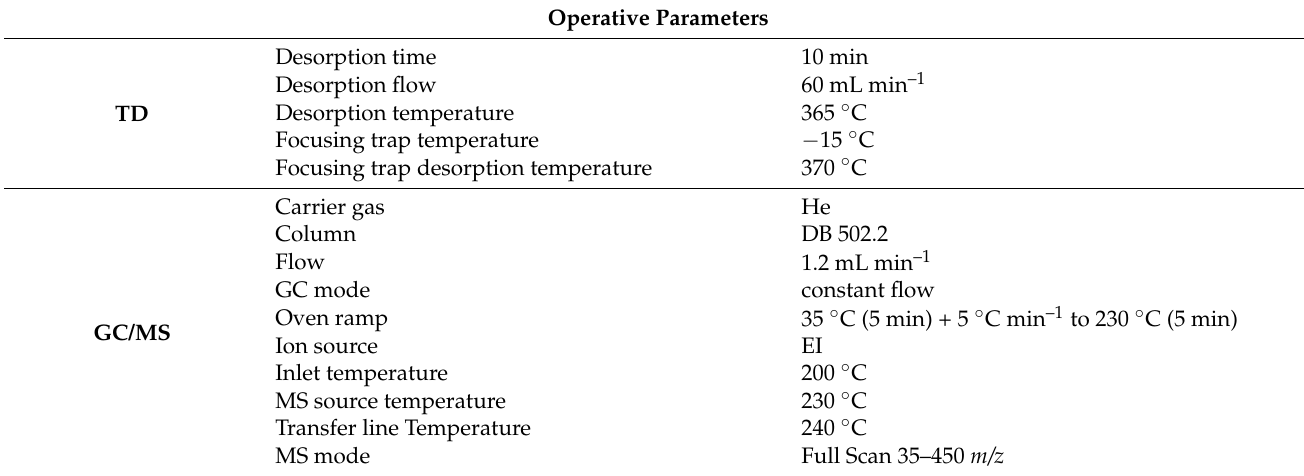
Table 2. Parameters used for thermal desorption-gas chromatography-mass spectrometry (TD-GC-MS). Operative